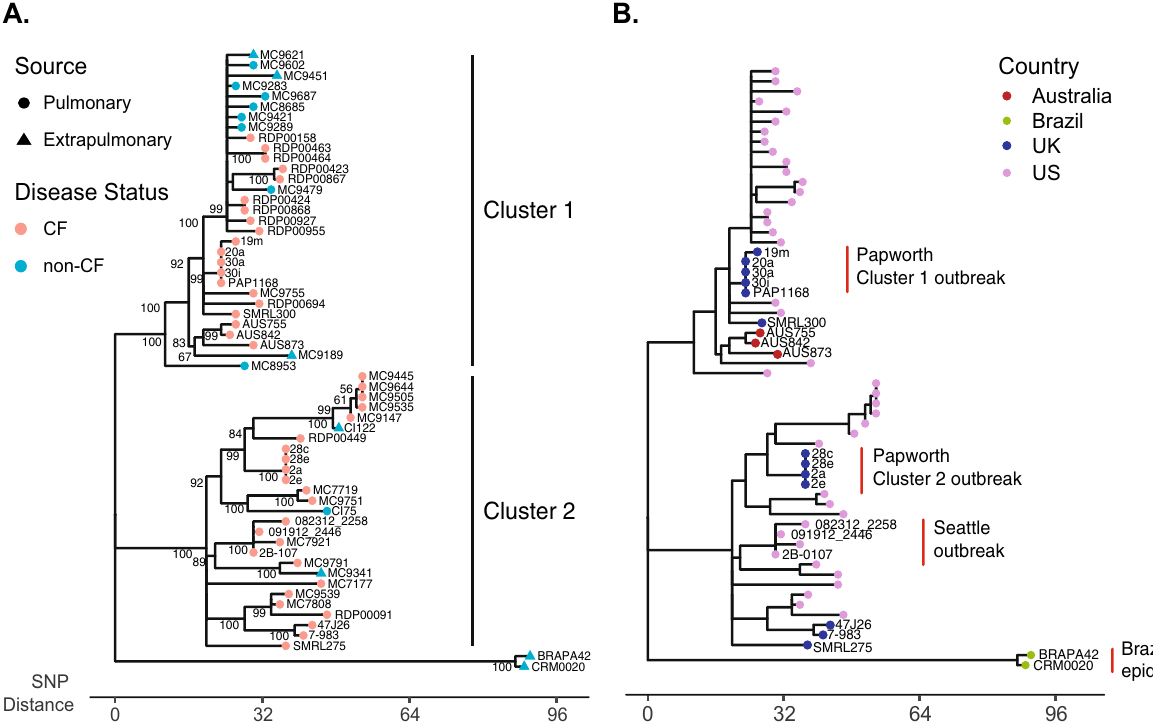
Figure 2. Phylogenetic relationships of Clone 1 isolates. ( A ) Phylogenetic reconstruction of Clone 1 isolates (n = 58) and two Brazilian epidemic isolates (n = 2) was generated using core genome SNP data and the neighbor-joining method. Bootstrap support values (> 50%) after 100 replicate searches are shown. Isolates are labeled by sample source and patient disease status. ( B ) The same phylogeny is labeled by isolate country of origin and previously studied outbreaks are labeled with red